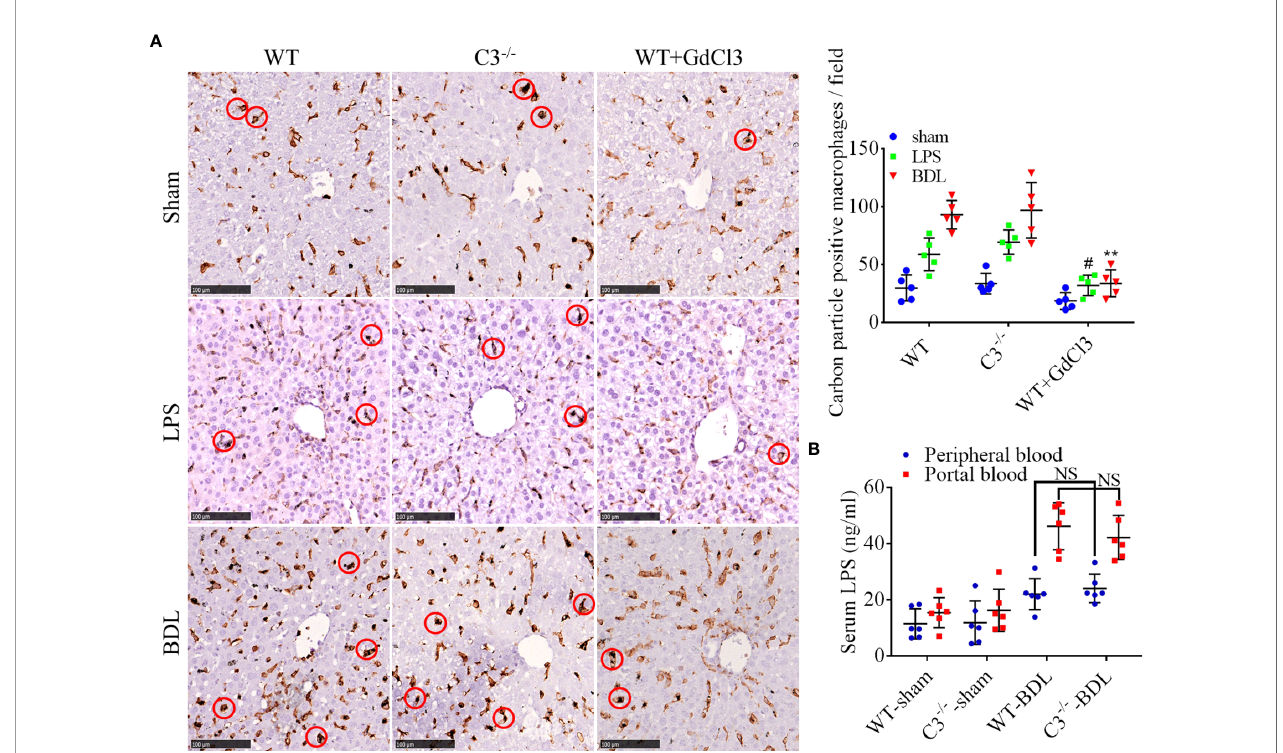
FIGURE 7 | C3 de fi ciency does not affect phagocytosis and clearance of LPS in mice with CLI. Wild-type (injected i.v. with GdCl3 or PBS) and C3 de fi cient mice were subjected to BDL or sham operations or injected i.p with LPS. The mice were injected i.v. with India ink 3 days later immediately before sacri fi ce. Formalin- fi xed, paraf fi n-embedded liver sections were immunostained for F4/80, and LPS was measured in serum samples. (A) Ability of macrophages to phagocytize carbon particles (scale bars, 100 m m; red circles, F4/80 positive cells containing carbon particles; n = 5 per group). (B) LPS concentrations in portal blood and peripheral blood (n =6 per group). Results are expressed as mean ± SD. # p < 0.01 compared with the WT-LPS or C3 − / − -LPS group; **p < 0.01, compared with the WT-BDL or C3 − / − -BDL group; NS, not signi fi